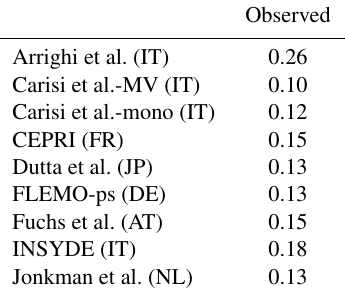
Table 5. Pearson’s correlation coefficient of observed damage and estimates supplied by the models with reference to the subset of buildings with claims. The abbreviations in parentheses indicate the original countries of the models (IT: Italy; FR: France; JP: Japan; DE: Germany; AT: Austria; NL: the Netherlands).